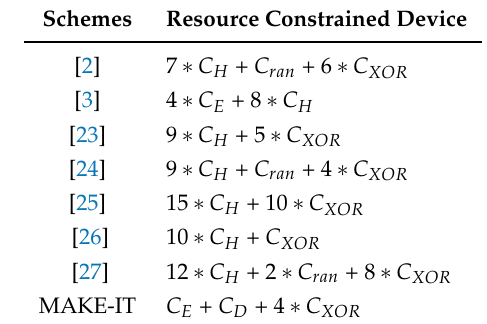
Table 5. Computation cost comparison with different schemes.